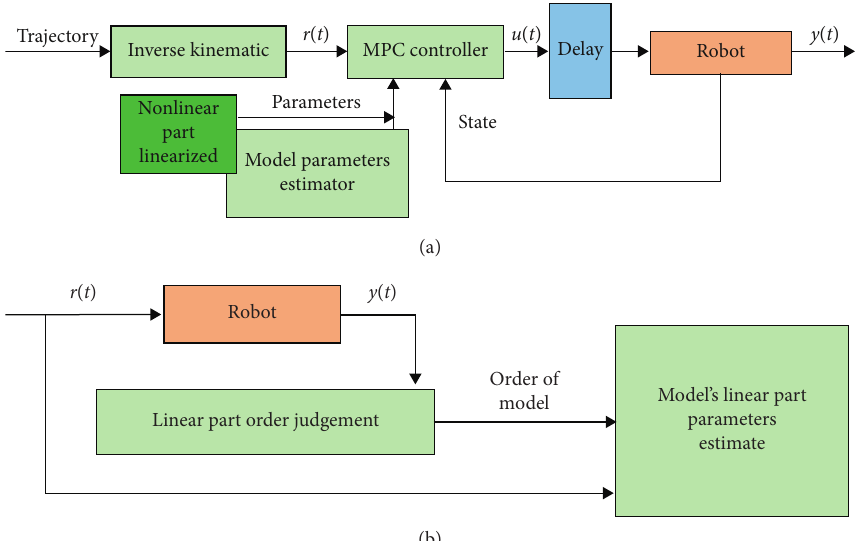
Figure 2: (a) The overall control framework of the surgical robot positioning system. (b) A schematic of the model parameter estimator of the linear part of the kinematics model.